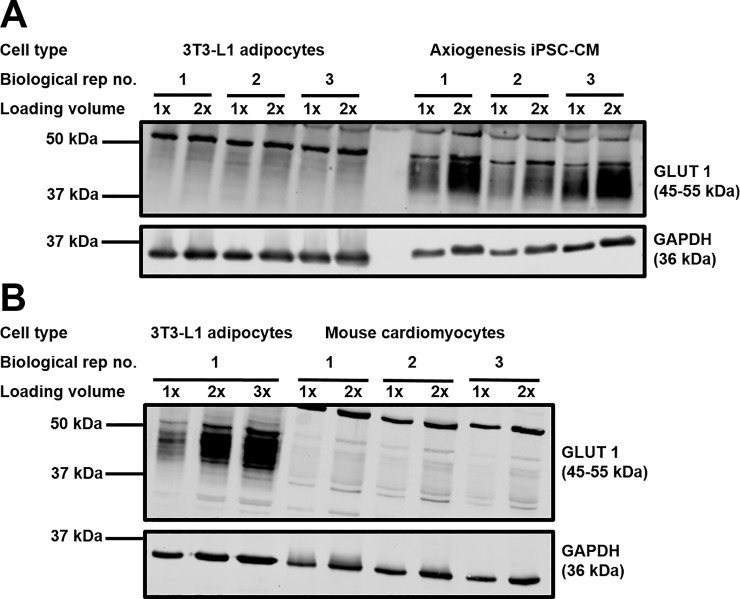
GLUT1 protein expression in different cardiomyocyte models.Protein lysates generated from 3T3-L1 adipocytes, primary adult mouse cardiomyocytes, and iPSC-CM were subjected to SDS-PAGE and immunoblotting. Lysates were incubated with antibodies probing for GLUT1 (1:1000, 1% milk, PBS-T) and GAPDH (1:80,000, 1% milk, PBS-T). Two different amounts of each sample of cardiomyocyte lysate from three biologically independent sources were loaded, in addition to at least three samples of 3T3-L1 adipocyte lysate. For each cell type, 1x refers to lysate generated from approximately 15,000 (3T3-L1 adipocytes panel A), 17,500 (iPSC-CM), or 45,000 (3T3-L1 adipocytes panel B) cells, or approximately 20 μg of protein (mouse cardiomyocytes). Panel A compares 3T3-L1 adipocytes and iPSC-CMs; Panel B compares 3T3-L1 adipocytes and primary mouse cardiomyocytes.